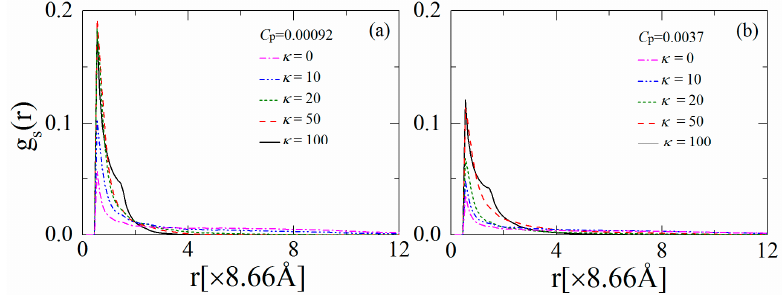
Figure 4. Distribution function for segments of the anchored polymers on the monolayer for various polymer chain rigidity parameters κ for ( a ) C p = 0.00092 and ( b ) C p = 0.0037. The results shown are for PC:PS:PIP 2 = 98:1:1.